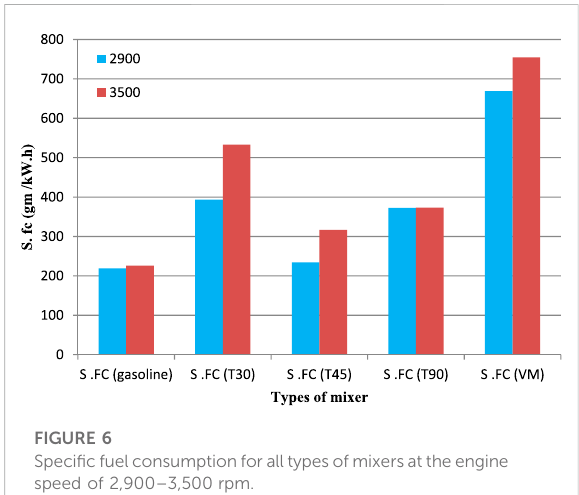
FIGURE 5 The relationship between engine speed and speci fi c fuel consumption for gasoline, T30, T45, T90, and VM.